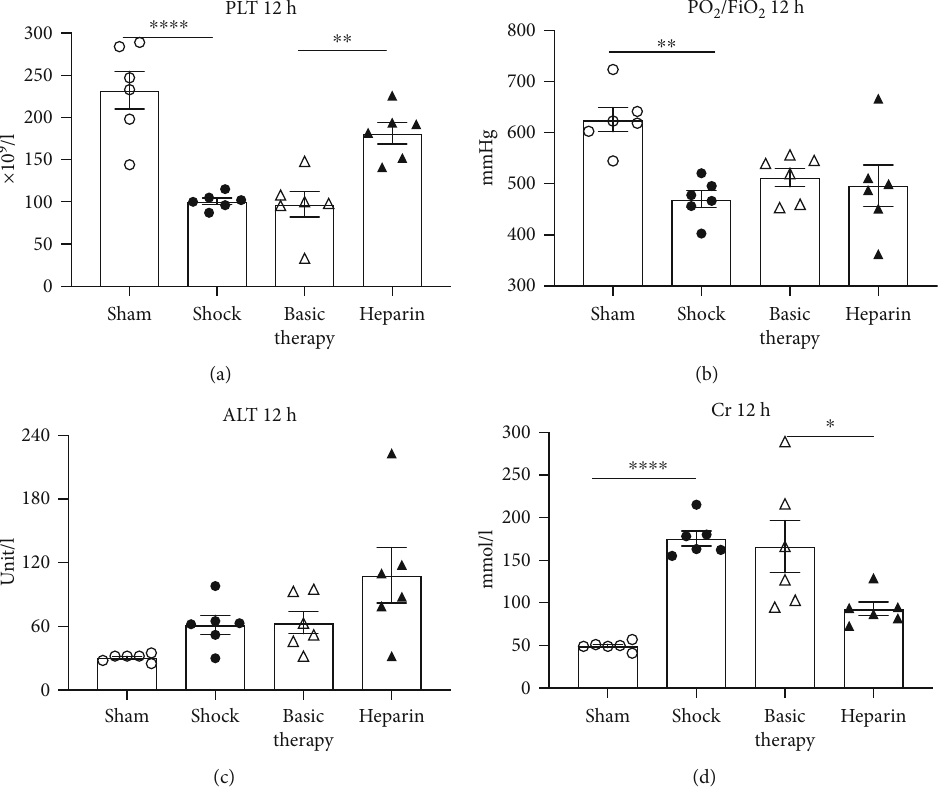
Figure 7: The e ff ect of UFH on organ function in septic shock. (a) Platelet counts were achieved from complete blood count. (b) PO was calculated from the arterial gas analysis results. (c, d) The alanine aminotransferase (ALT) and creatinine (Cr) levels in the blood were collected from biochemical analysis at T12. ∗ P < 0 : 05 ; ∗∗ P < 0 : 01 ; ∗∗∗∗ P < 0 : 0001